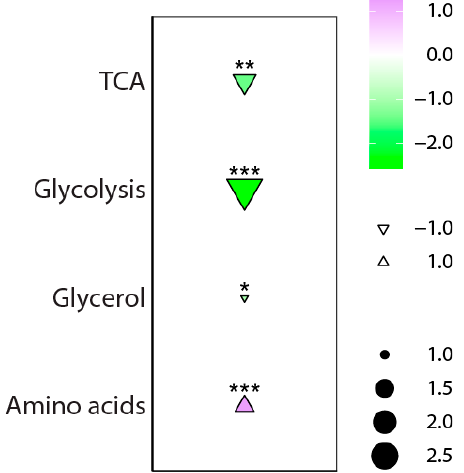
Figure 1. Levels of detected central carbon metabolites in HUVEC cells after serum starvation for 24 h compared to basal conditions. Metabolites were minimum/maximum-normalized and grouped according to the biological classes to show the overall effects of serum starvation. The colors and triangles indicate the direction and effect size (serum starvation relative to basal). The sizes of the dots indicate log2 fold changes in the means of the normalized peak areas of serum starvation versus the basal condition. Significance was calculated using the Mann–Whitney U test. Significant values: p < 0.05 (*), p < 0.01 (**) and p < 0.001 (***). n = 9 basal and n = 10 serum-starved. TCA: tricarboxylic acid cycle.